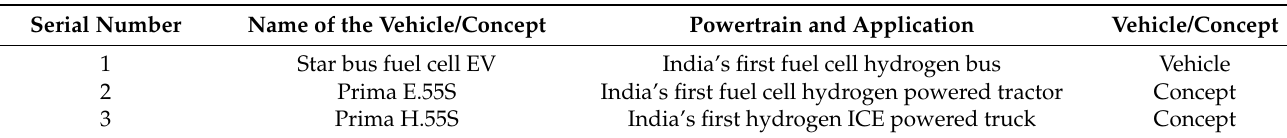
Table 10. List of vehicles/concepts revealed at Auto Expo 2023 related to hydrogen and fuel cells by Tata Motors